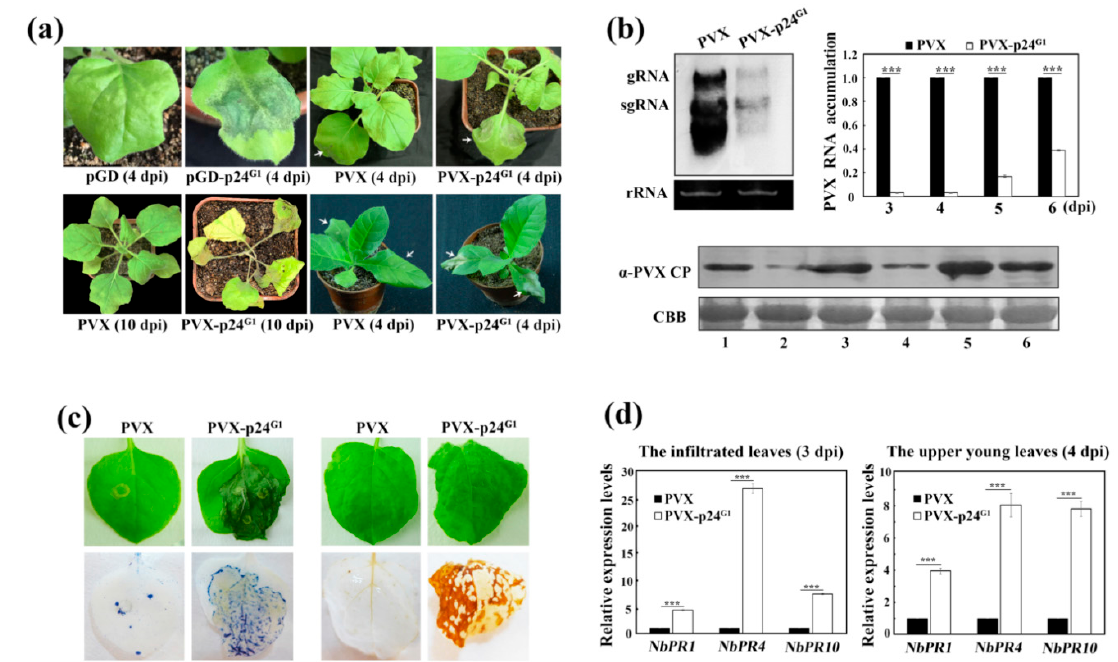
Figure 2. p24 of grapevine leafroll-associated virus 1 (p24 G1 ) elicits necrosis in Nicotiana species when expressed from pGD or PVX vector. ( a ) Phenotypes of N. benthamiana and N. tabacum induced by p24 G1 expressed from pGD- or PVX-based vector. Arrows indicate infiltrated leaves. ( b ) Quantitative assessment of PVX accumulation. The upper young leaves of PVX–p24 G1 - or PVX-infected N. benthamiana plants at 3, 4, 5 and 6 dpi were used for RNA and protein extraction. The upper left panel shows PVX RNA accumulation at 5 dpi detected by Northern blot. The detected bands corresponding to PVX genomic and subgenomic RNA are indicated as gRNA and sgRNA, respectively. The upper right panel shows PVX RNA accumulation at 3, 4, 5 and 6 dpi detected by qRT-PCR. The lower panel shows PVX CP accumulation at 4 (lanes 1, 2), 5 (lanes 3, 4) and 6 (lanes 5, 6) dpi detected by Western blot using PVX CP-specific antiserum. Odd and even lane numbers indicate samples from PVX- and PVX–p24 G1 -infected plants, respectively. Ethidium-bromide-stained rRNA and CBB staining are shown as loading controls. ( c ) Trypan blue and DAB staining. Cell death was estimated by Trypan blue staining of infiltrated leaves at 4 dpi. H 2 O 2 accumulation was assessed by DAB staining of upper noninfiltrated leaves at 5 dpi. Representative leaves before and after staining are shown. ( d ) E ff ect of p24 G1 expressed from PVX vector on the transcript levels of NbPR1 , NbPR4 and NbPR10 . Total RNA was extracted from the infiltrated (3 dpi) and upper young (4 dpi) leaves. qRT-PCR results (b,d) are shown as mean ± standard deviation of three independent experiments. Standard deviation is denoted by error bars. *** p < 0.001.